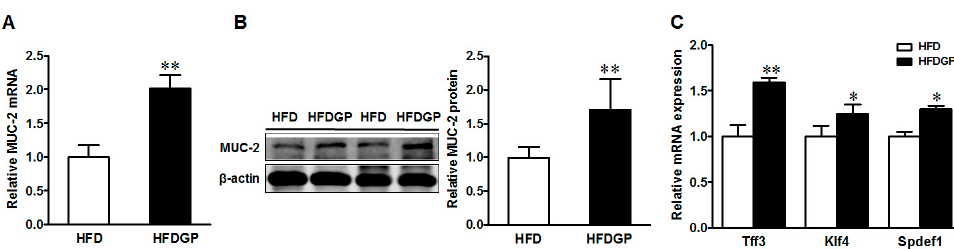
Figure 4. Mucin-2 and goblet cell differentiation markers in the colon of HFD or HFDGP fed DSS-colitis mice. ( A ) mRNA expression of MUC-2; ( B ) representative immunoblotting bands and statistical data of mucin 2; ( C ) mRNA expression of goblet cell differentiation markers, Tff3, Klf4, and Spdef1. Means ± SEM, n = 7, * p ≤ 0.05, ** p ≤ 0.01.